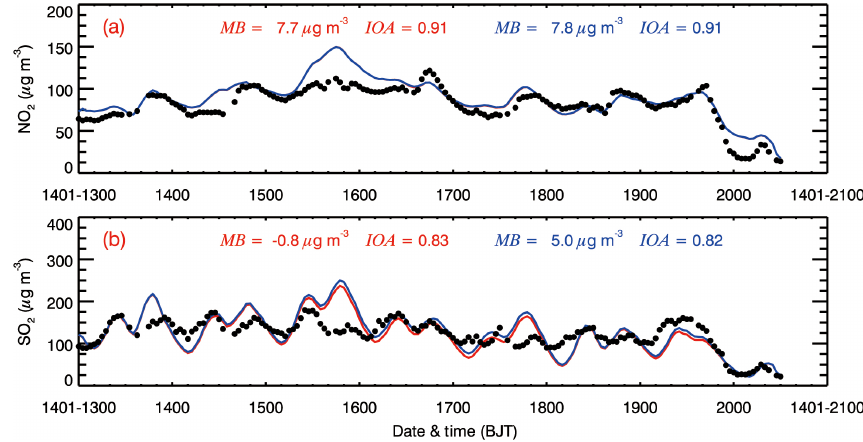
Figure 10. Same as Fig. 9, but in BTH from 13 to 21 January